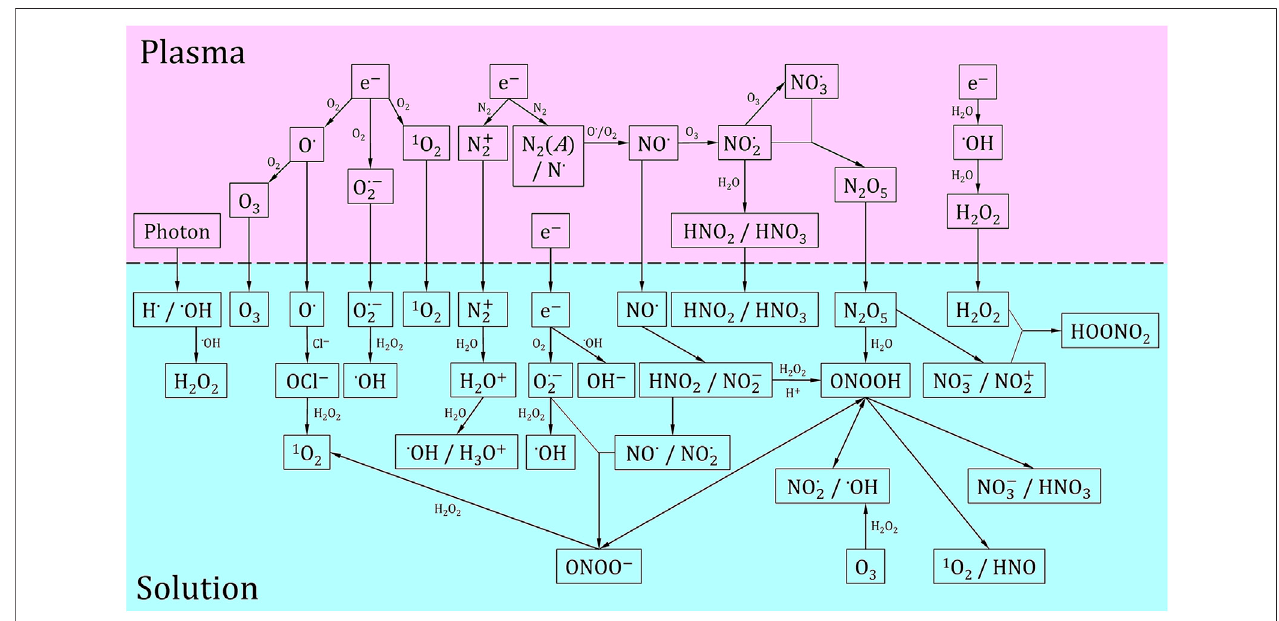
FIGURE5| Schematicofkeyplasma-producedspeciesrelevanttovirusinactivation.Reactionpathwaysarealsoprovidedbothinthegasphaseandliquidphase. In the liquid phase, we also show the production of radicals from long-lived plasma produced chemistry. The horizontal dashed line represents the plasma-liquid interface. This set of reactions is a compilation of the reactions that are believed to be dominant for virus inactivation and is adapted from [59, 94, 184, 238, 239].